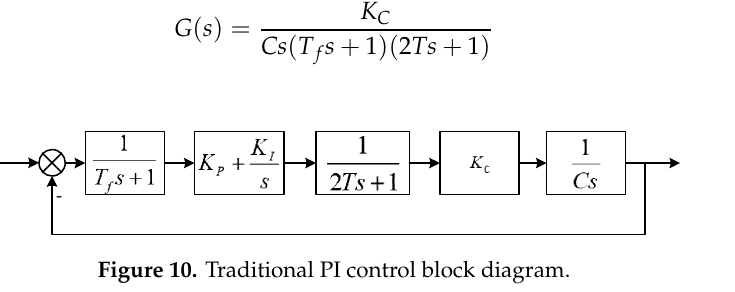
Figure 10. Traditional PI control block diagram.